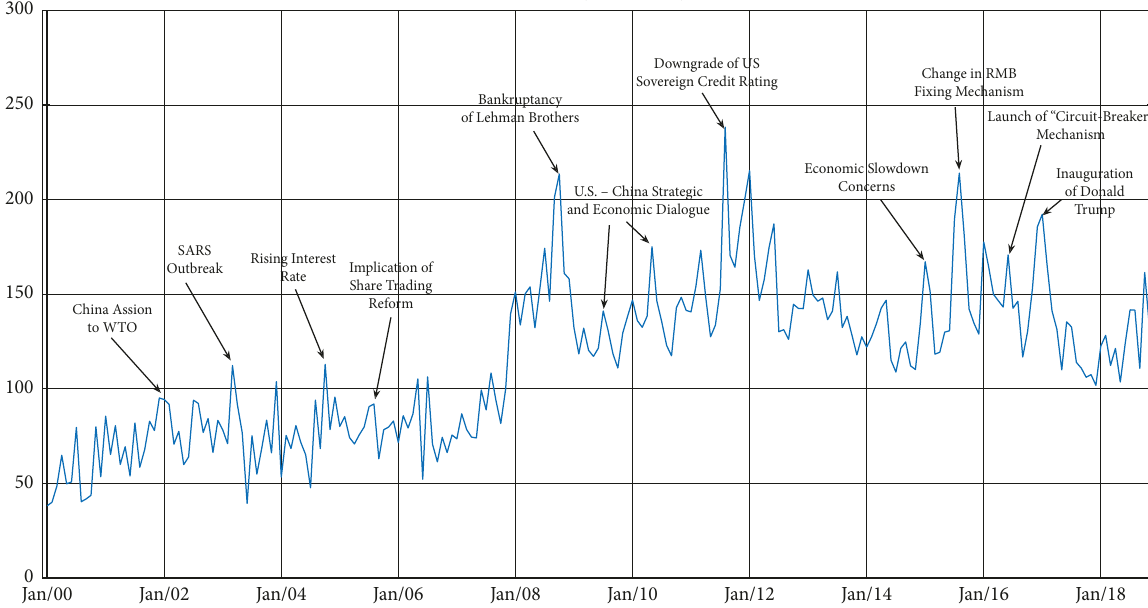
Figure 2: EPU index of China. Notes: the index is available at https://economicpolicyuncertaintyinchina.weebly.com.